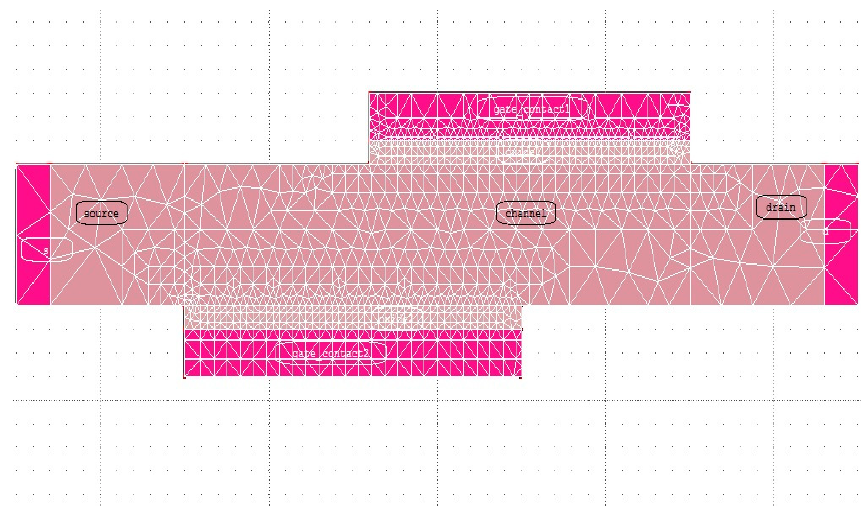
Figure 2. The meshing of the heavily n + -doped pocket AJ DG MOSFET in TCAD. Table 1. Dimensions of the AJ DG MOSFET with n + pocket region.